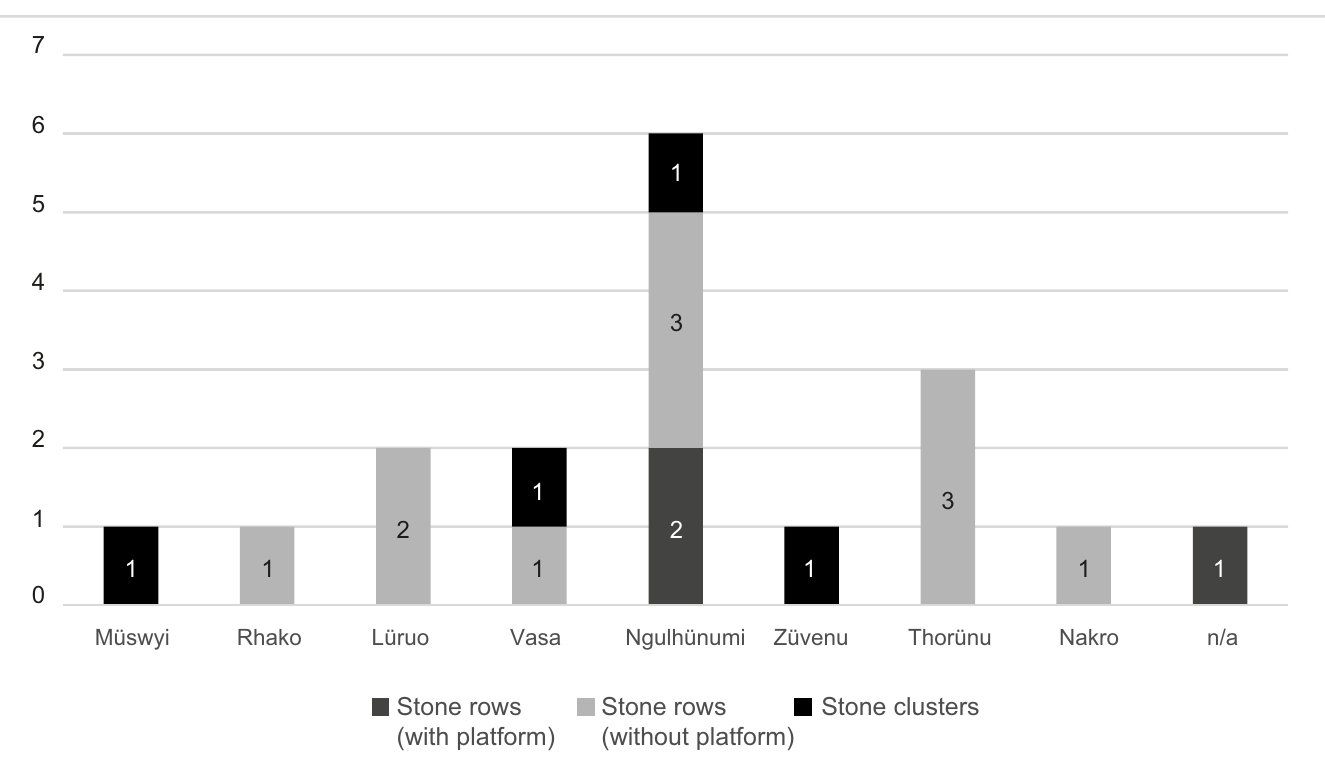
Fig 12. Diagram of the different monument types per clan in the Chakhesang Naga village of Ru¨nguzu (graphic: M. Wunderlich).